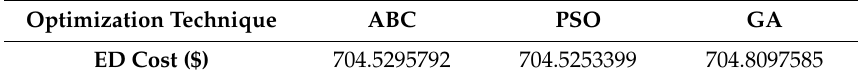
Table 6. Generation cost of each optimization technique used in the Economic Dispatch